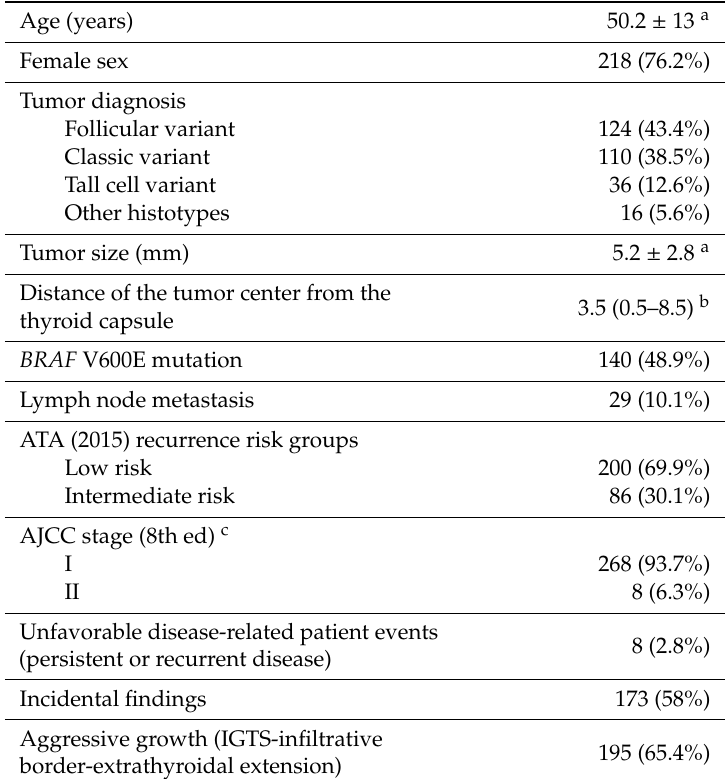
Table 1. Clinicopathologic characteristics (Total: 286